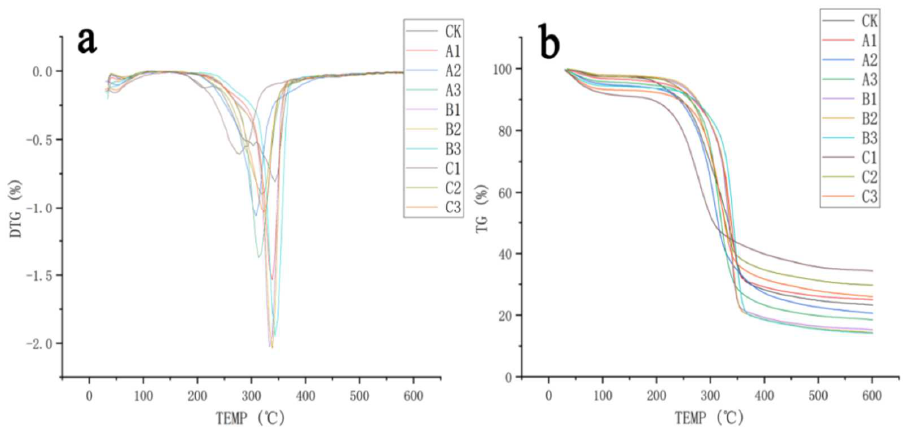
Figure 5. ( a ) Derivative thermogravimetry (DTG) and ( b ) thermogravimetric analysis (TGA) curves of different bamboo fiber